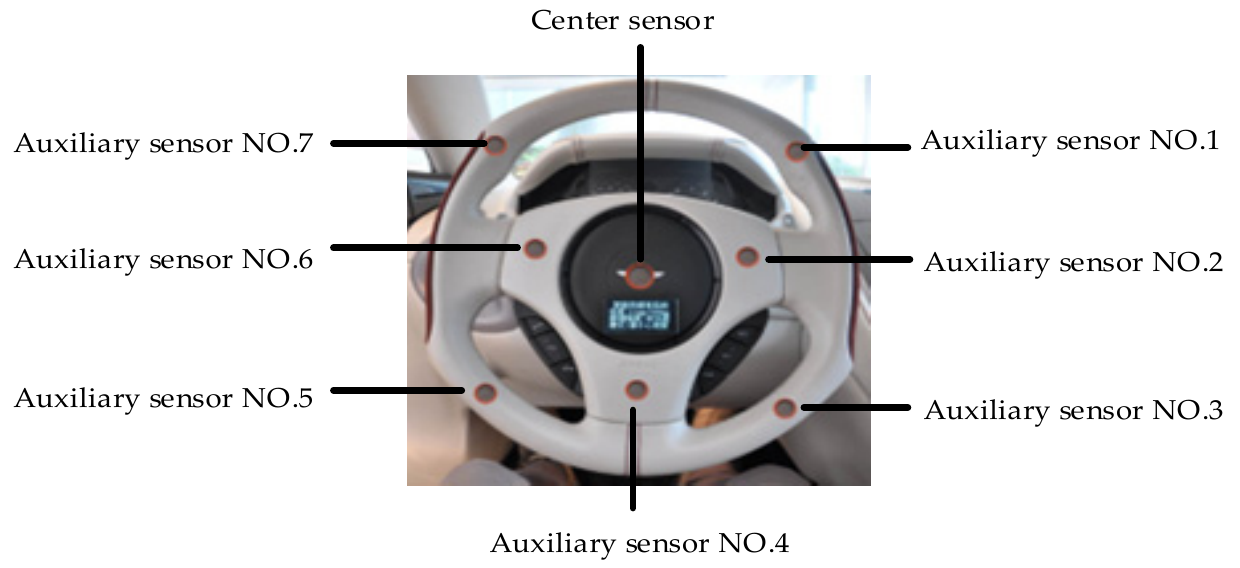
Figure 2. Physical view of sensor array. Table 1. Description of ethanol diffusion in the